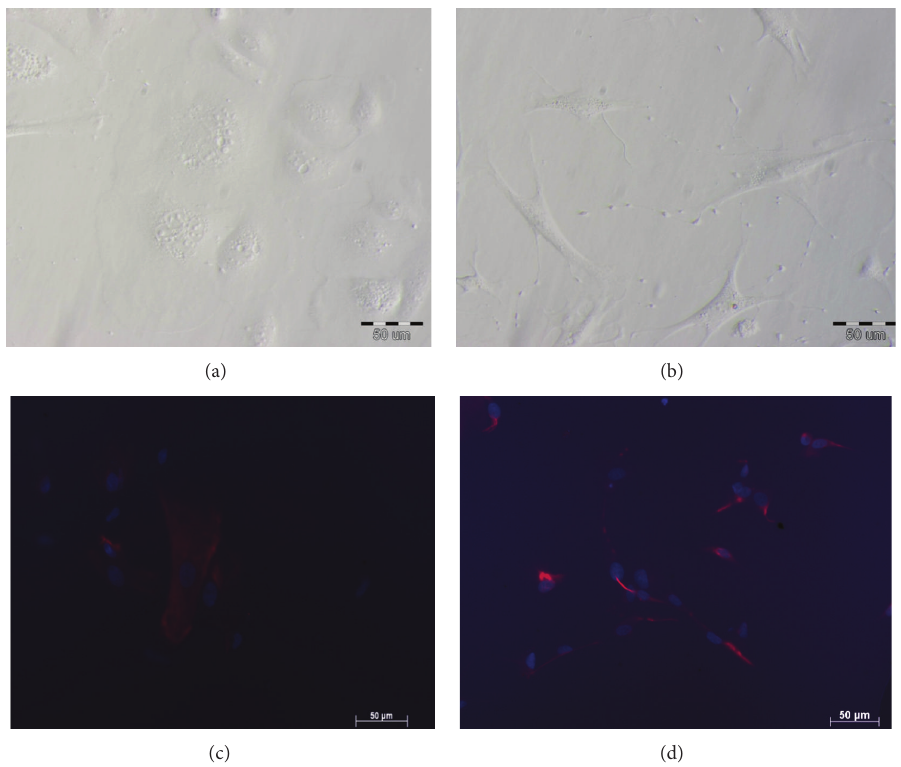
Figure 1: Representative morphology of cultured equine endometrial: (a) epithelial cells and (b) stromal cells. (c) Epithelial cells identification by immunofluorescent staining for cytokeratin; (d) stromal cells identification by immunofluorescent staining for vimentin. The scale bar = 50 𝜇 m (magnification: ×